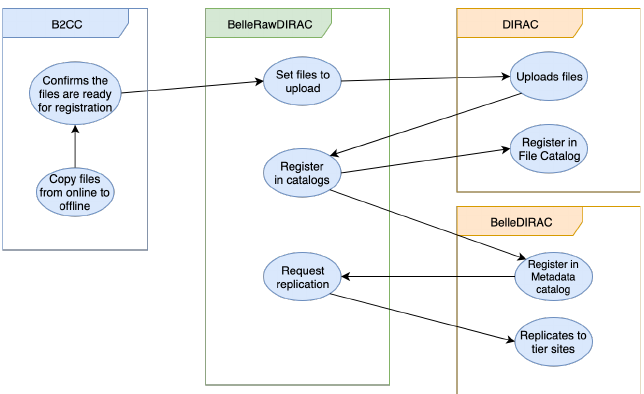
Figure 1. Workflow diagram of the Raw Data Management system. The Online-O ffl ine data operations system (B2CC) submits a list of files to be registered and replicated. Then the Raw Data Management system, the main component of BelleRawDIRAC, processes them in communication with systems im- plemented in DIRAC and